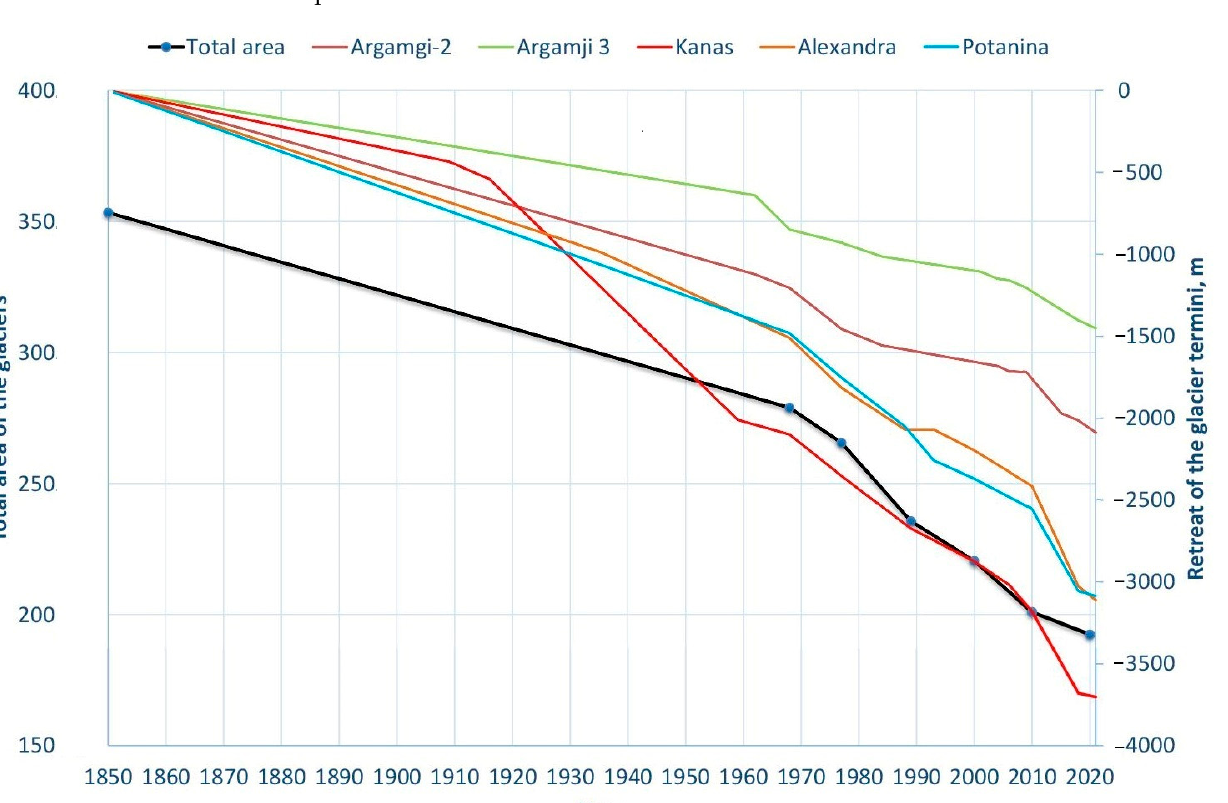
Figure 10. Changes of the total area of the glaciers of Tavan Bogd and the retreat of the termini of 5 valley glaciers of the same glacial center after the LIA maximum.